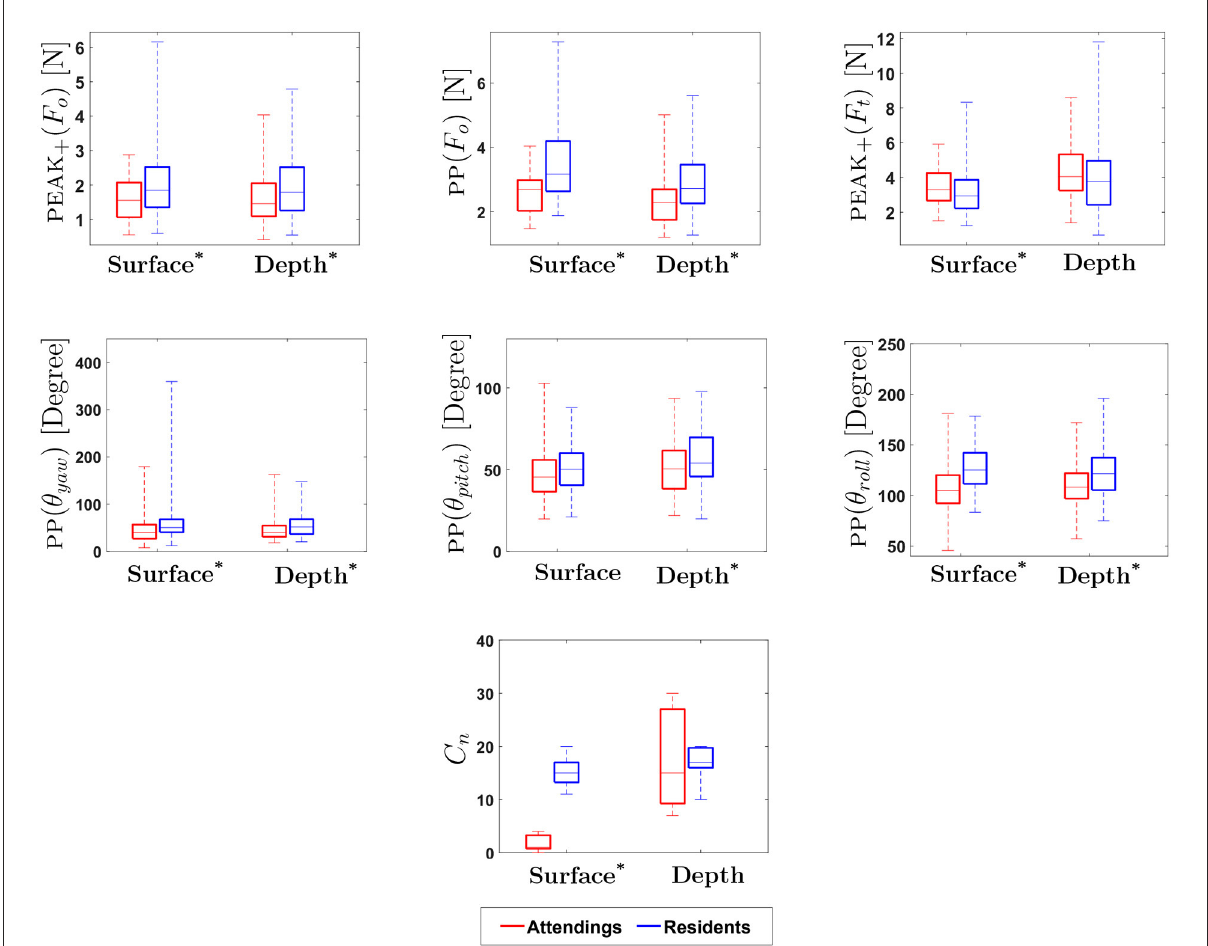
FIGURE9 Experimental Results for Motion-based, Physical Contact and Vision-enabled Force Metrics: * indicates statistical significance for p < 0.05. (On each box, the middle line indicates the median, and the bottom and top edges of the box indicate the 25 and 75 th percentiles, respectively. The whiskers are extended to the most extreme data points including